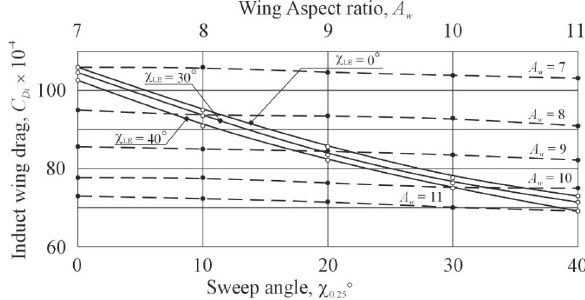
Figure 4. Dependence С Di on sweep and wing aspect ratio with η = 1/3.5; С L = 0.45; S w =